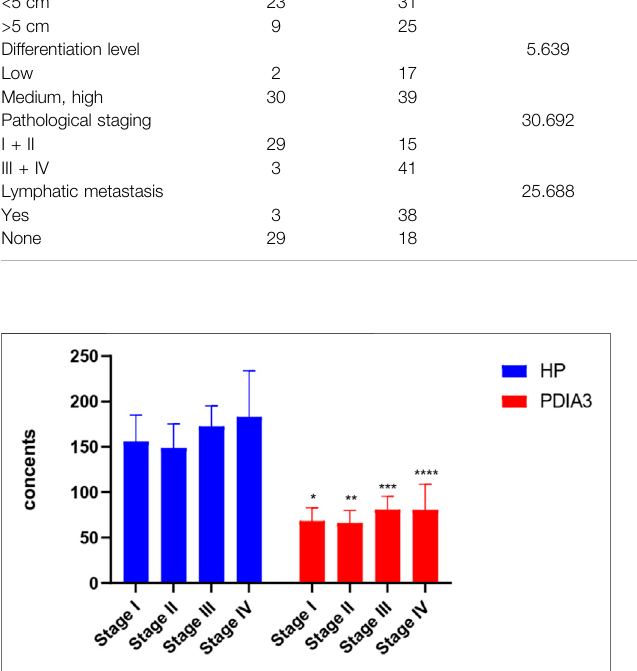
FIGURE 4 | HP and PDIA3 serum contents of patients at different pathological stages. In the Stage I, the average contents of HP and PDIA3 are 156 ± 29 μ l/ml and 68 ± 15 ng/ml. In the stage II, the average contents of HP and PDIA3 are 149 ± 26 μ l/ml and 66 ± 14 ng/ml. In the stage III, the average contents of HP and PDIA3 are 173 ± 23 μ l/ml and 81 ± 15 ng/ml. In the stage IV, the average contents of HP and PDIA3 are 183 ± 51 μ l/ml and 80 ±28 ng/ml( p < 0.05).*vs.Stage I( p < 0.05),** vs. Stage II( p < 0.05),***vs. Stage III ( p < 0.05), ****vs. Stage IV ( p < 0.05).